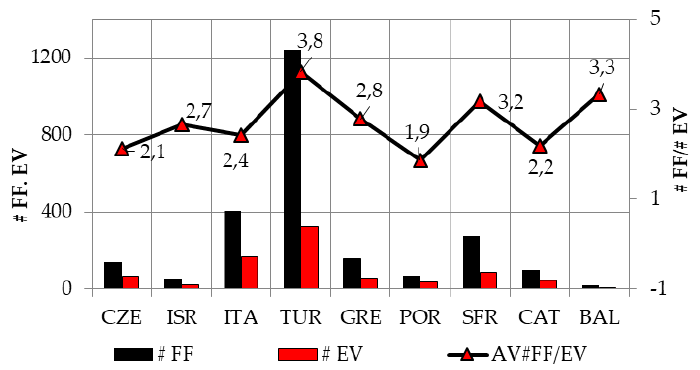
Figure 2. Number of fatalities (#FF), number of events (#EV) and mean number of fatalities per event (AV#FF/EV).